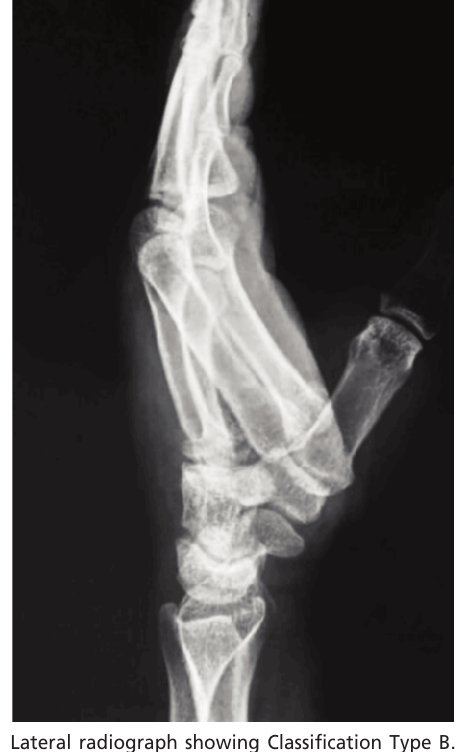
Lateral radiograph view showing Classification Type A. Fig. 1: Dorsal dislocation of multiple metacarpals without any associated fractures.